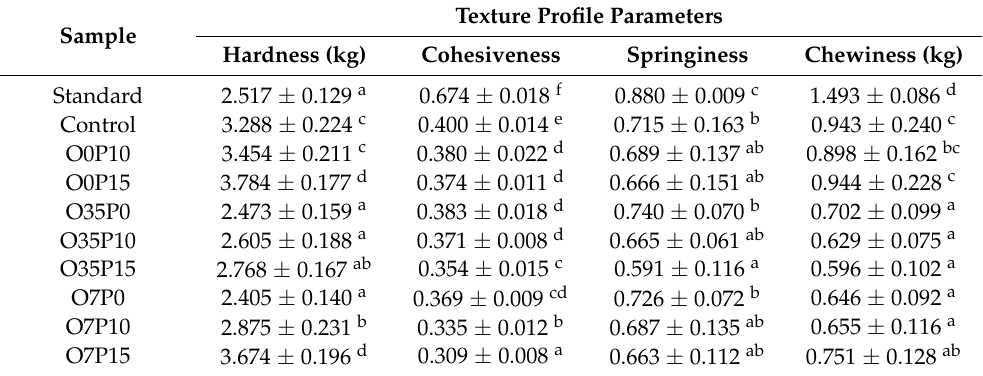
Table 4. Texture profile of wheat flour cake (standard) and different formulations of Saba banana flour cakes.